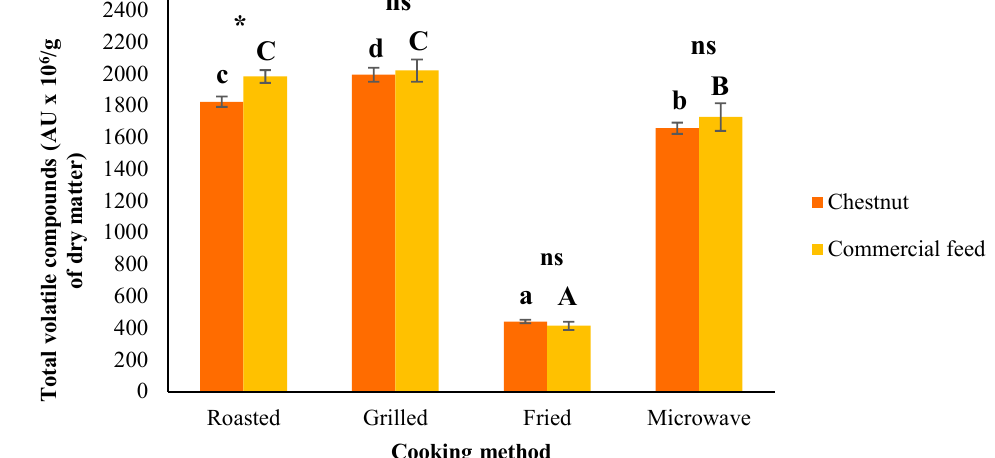
Figure 2. Effects of the inclusion of chestnut in the finishing diet and cooking methods on total volatile compounds of Celta pig Biceps femoris (mean ± standard error). Influenced by feeding: * ( P < 0.05); ** ( P < 0.01); *** ( P < 0.001); ns: no significant difference. Different letters within the same feeding regimen (chestnut ( a,d ) or commercial feed ( A,C )) indicate significant differences for cooking methods ( P < 0.05) .